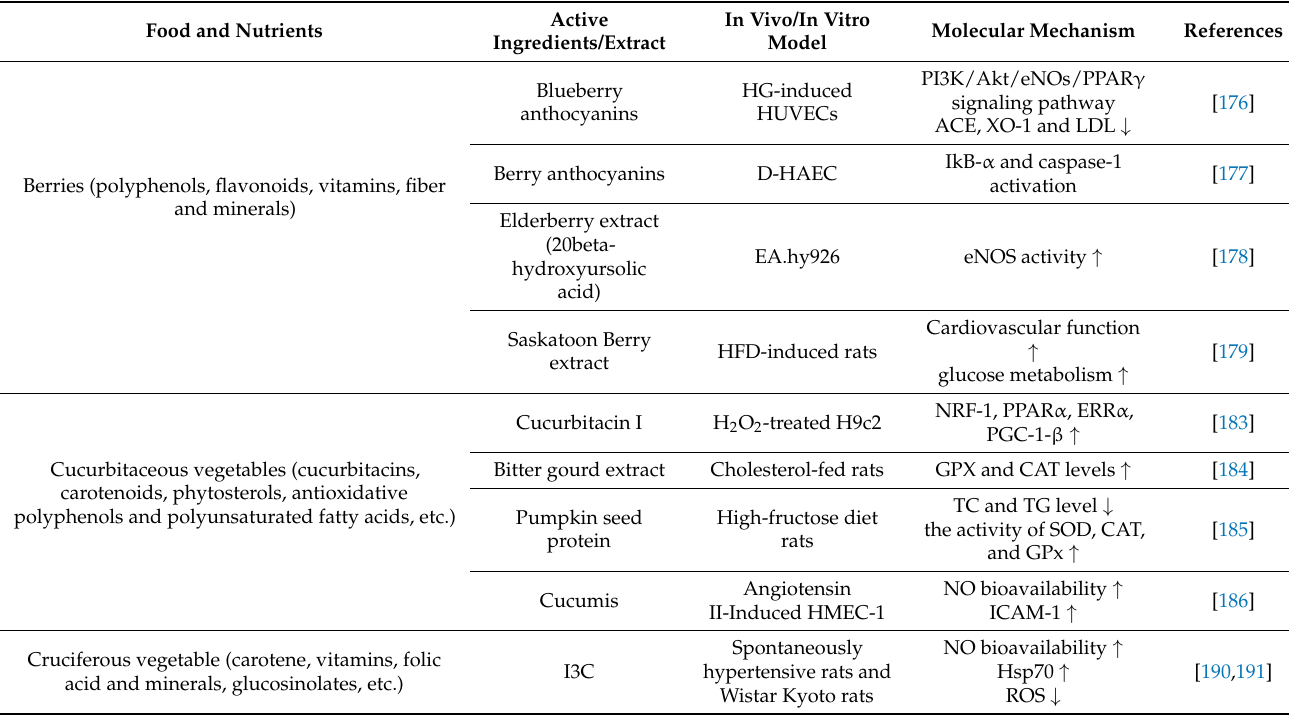
Table 3. Antioxidant effects of functional food and their bioactive compounds in improving cardio- vascular disease in experimental settings. ↑ : upregulation; ↓ :